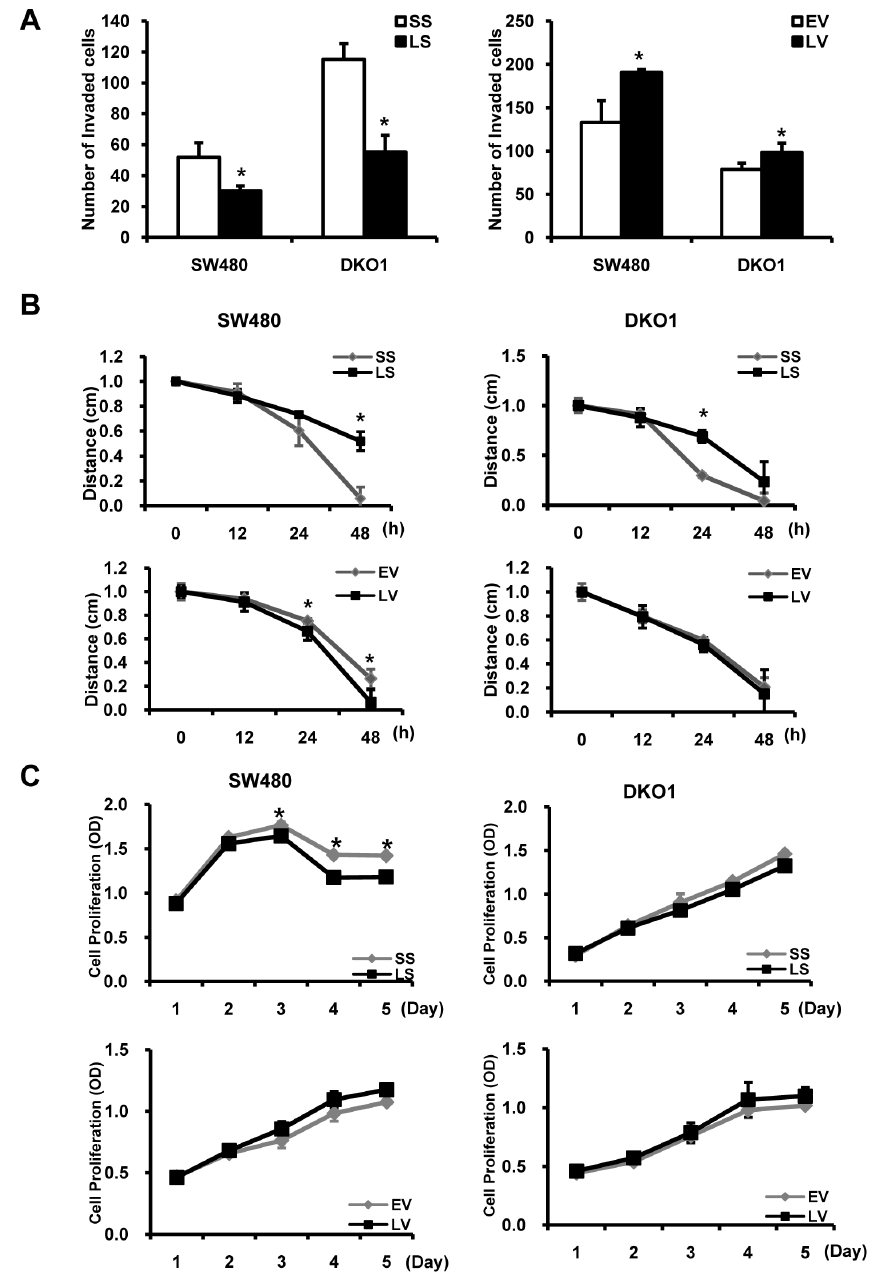
Figure 1. The impact of Livin on invasion, migration and proliferation of human colorectal cancer cells. (A) The impact of Livin on invasion of colorectal cancer cells. The invasion assay using the siRNA or pcDNA3.1-transfected cells was performed. Stained invading cells were counted and are represented as a graph between groups. The number of LS-transfected cells that invaded was significantly lower than that of SS-transfected cells. The number of invading cells was significantly higher in LV- transfected cells compared to EV-transfected cells (mean±standard error [SE], n=6; *p<0.05). (B) The impact of Livin on migration of colorectal cancer cells. The wound healing assay using siRNA or pcDNA3.1-transfected cells was performed and graphs of cell migration are displayed as relative healing distances. Cell migration was significantly disturbed in LS-transfected SW480 and DKO1 cells and increased in LV-transfected SW480 cells (mean±SE, n=3; *p<0.05). (C) The impact of the Livin on proliferation of colorectal cancer cells. The absorbance indicating proliferating viable cells decreased in the LS-transfected SW480 cells but there was no significant difference of cell proliferation between LV and EV transfected cells (mean±SE, n=3; *p<0.05). SS; scramble siRNA, LS; Livin siRNA, EV; Empty-pcDNA3.1, LV; pcDNA3.1-Livin. doi: 10.1371/journal.pone.0073262.g001 PLOS ONE |